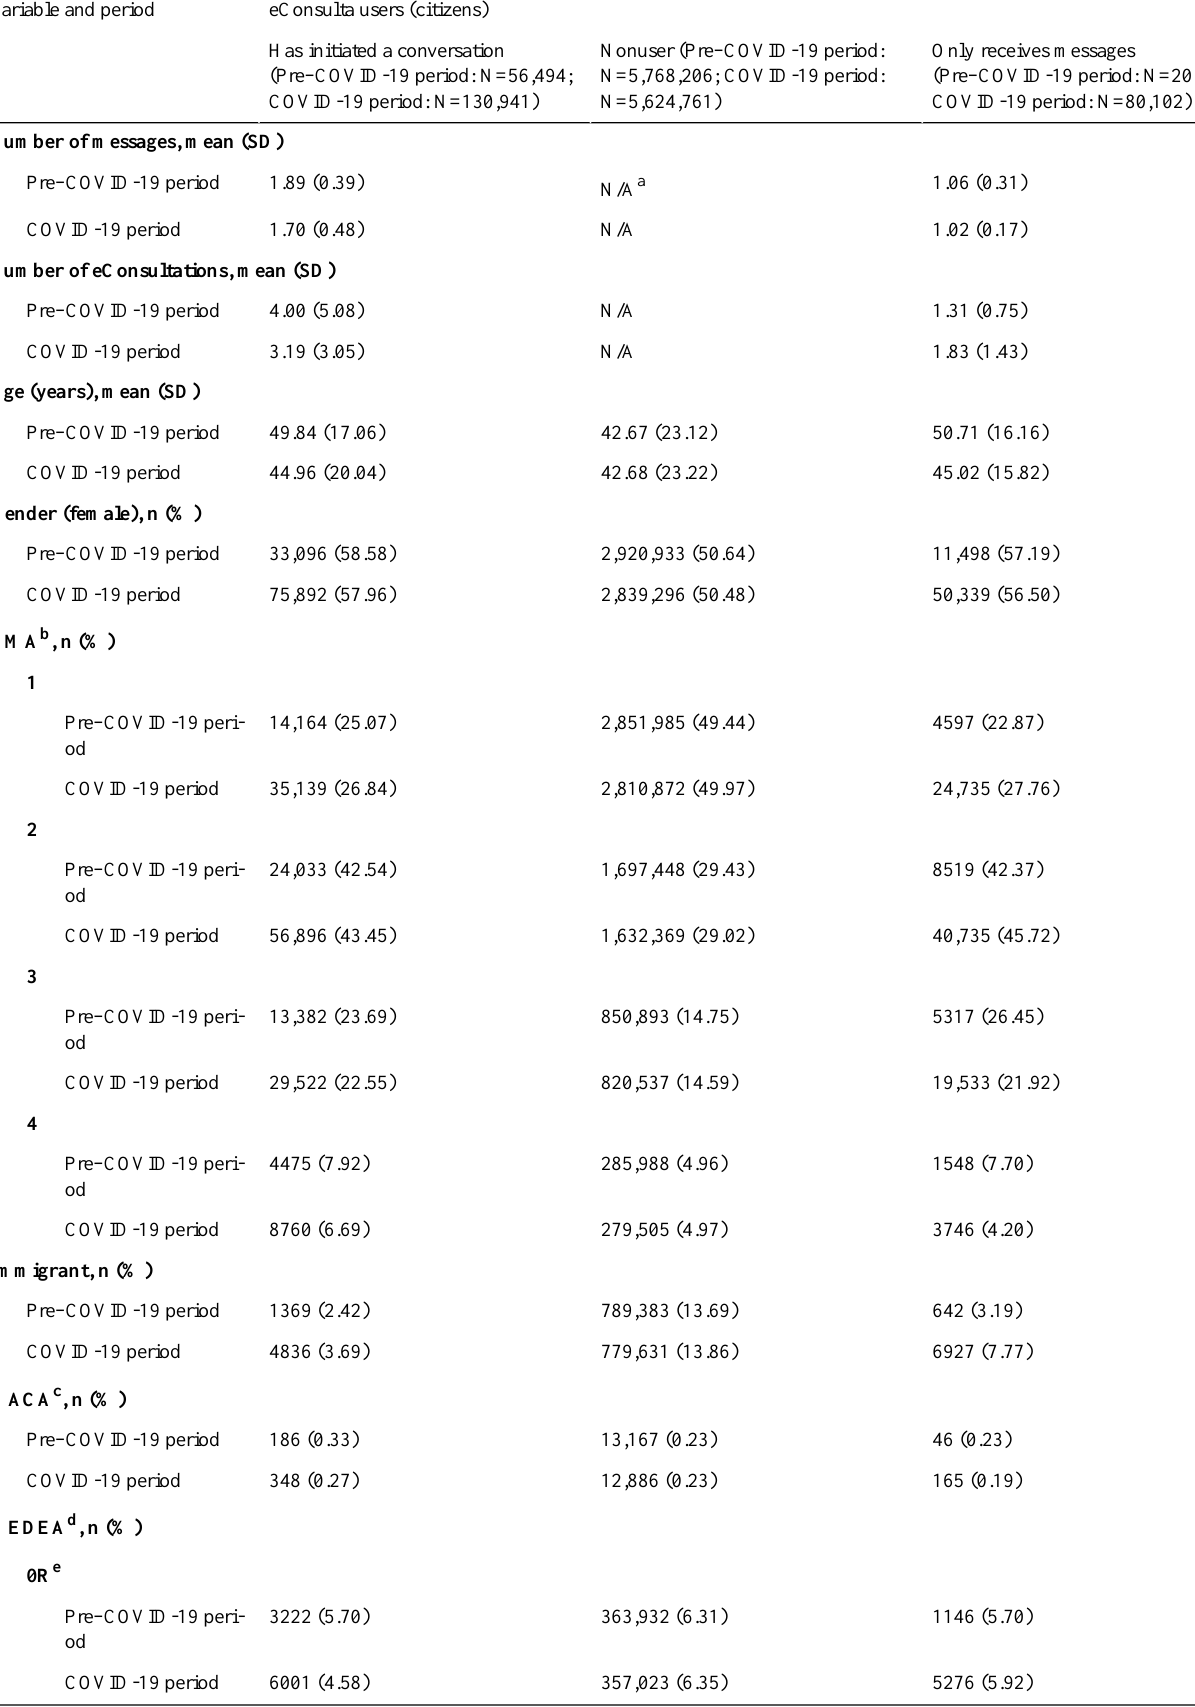
Table 1. Characteristics of citizens who use eConsulta (Source dataset: [20]).